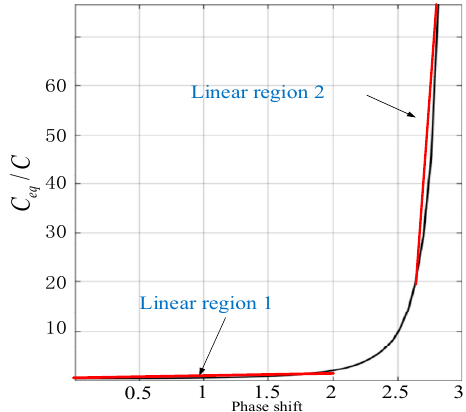
Figure 6. Equivalent capacitance of the full-wave SCC versus phase shift.